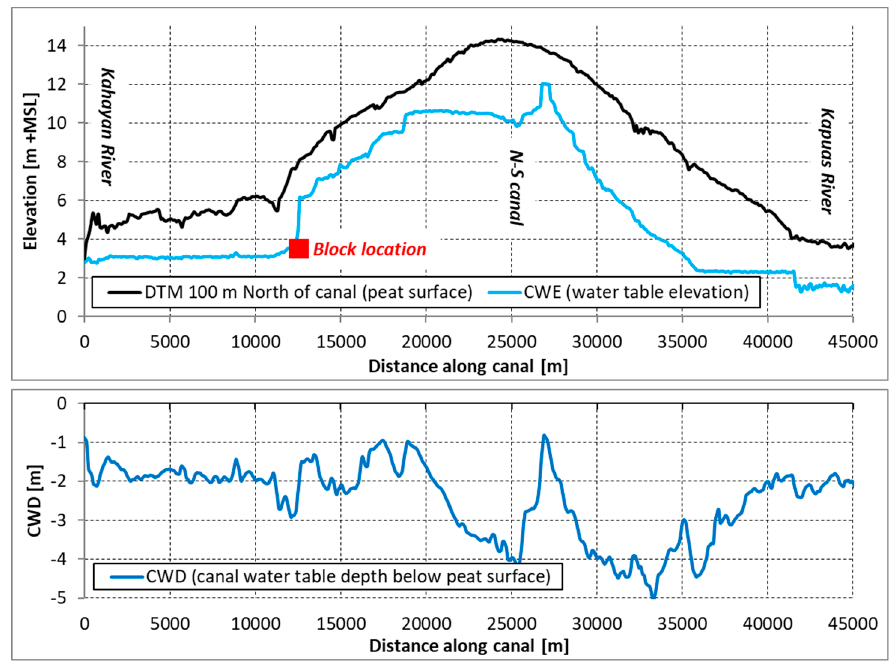
Figure 8. Demonstration of CWE and CWD patterns along cross section A in Figure 7.